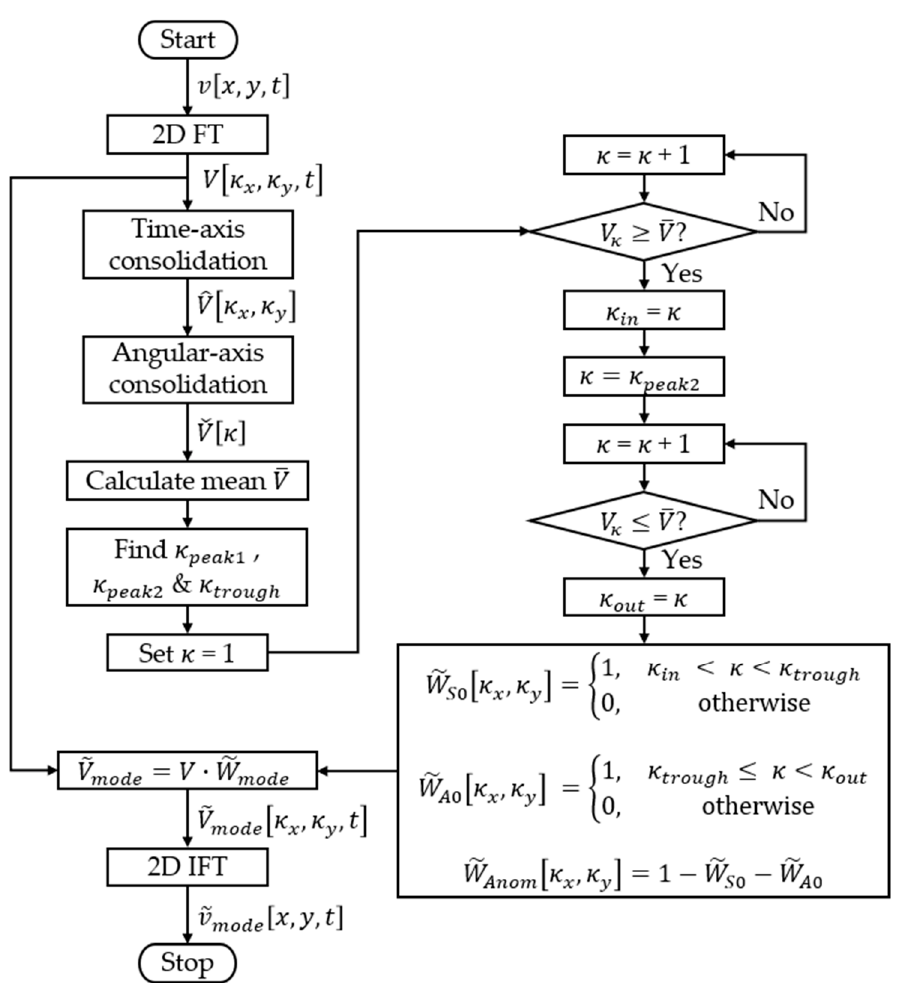
Figure 2. Flowchart showing a detailed process of the proposed adaptive mode fi lter.